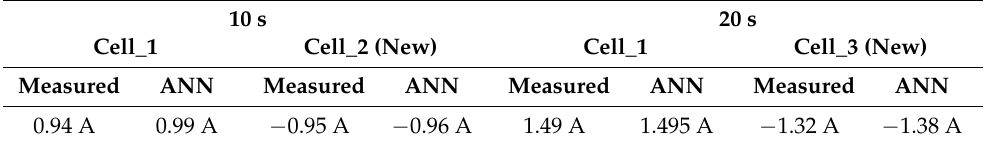
Table 9. Comparison of peak current estimation results and experimental results during hot